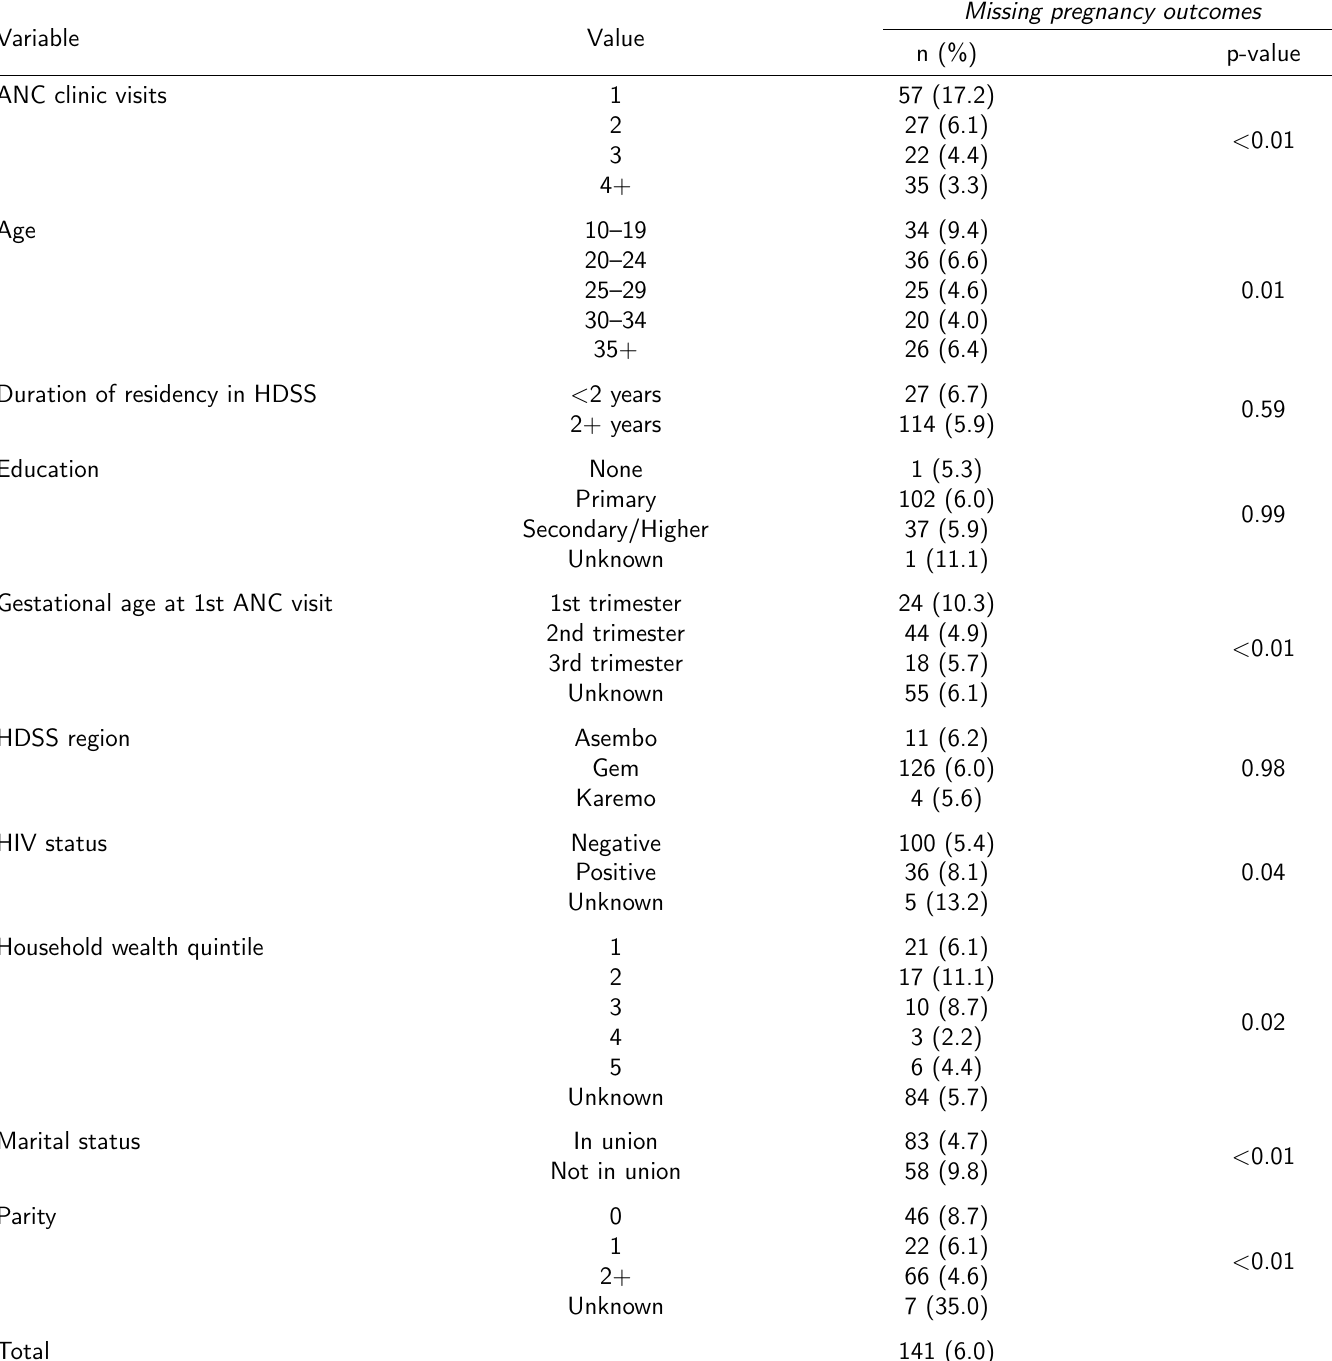
Table 2: Characteristics of linked women that were missing pregnancy outcome reports in the